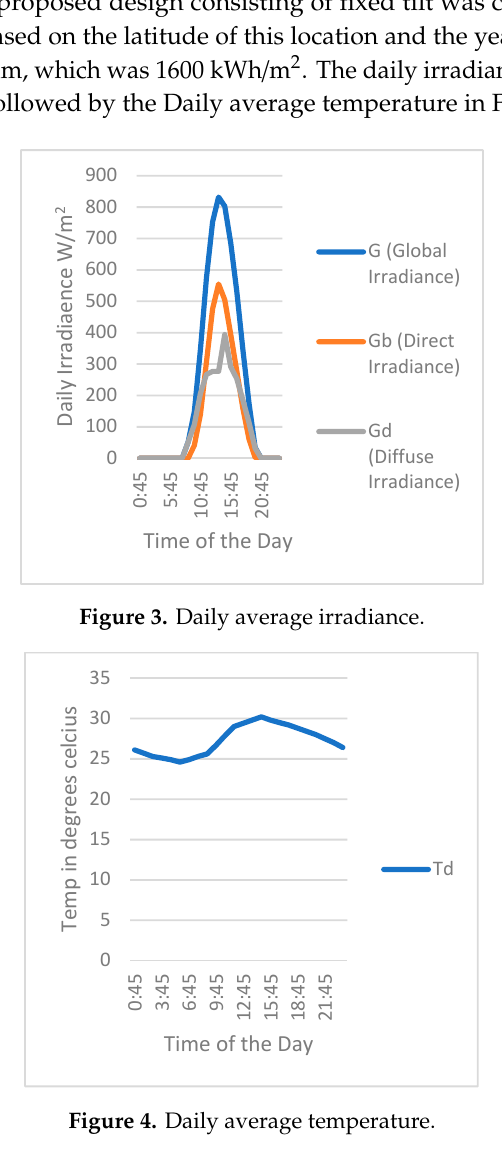
Figure 4. Daily average temperature.